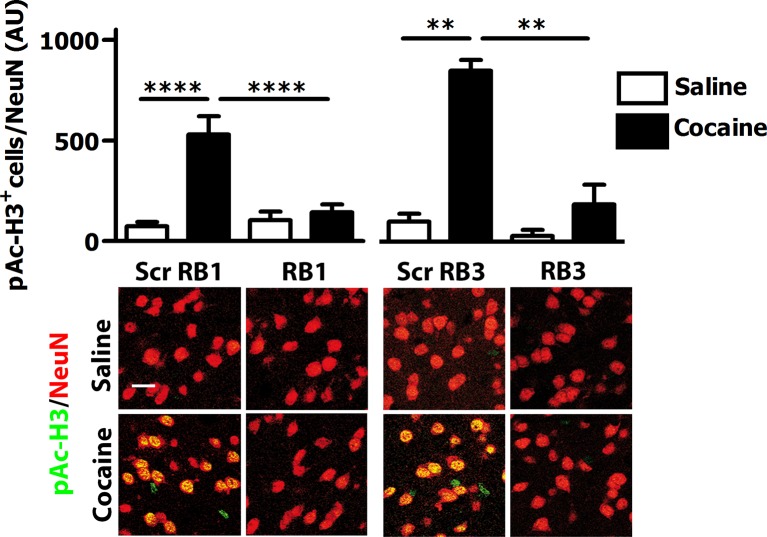
RB1 and RB3 have an inhibitory effect on cocaine-induced H3 phosphorylation.RB1 (20 mg/kg, i.p.), RB3 (20 mg/kg, i.p.) or the scrambled peptides (Scr RB1 and Scr RB3, 20 mg/kg, i.p.) were administered to wild type mice 1 hr before an acute cocaine (25 mg/kg) or saline injection. After 20 min mice were perfused. Co-labelling was performed with anti-phospho (Ser10)-acetyl (Lys14) histone H3 (in green) and NeuN (in red, scale bars 30 μm). Neuronal quantification shows a significant inhibitory effect of RB1 and RB3 on cocaine-induced H3 activation in the ventral striatum. Two-way ANOVA: effect of RB1 F1,32 = 10.29, p<0.01, effect of cocaine F1,32 = 19.91, p<0.001, effect of interaction F1,32 = 13.99, p<0.001; Bonferroni’s post-hoc, Scr RB1 saline (n=9) vs Scr RB1 cocaine (n=9) p<0.0001, Scr RB1 cocaine (n=9) vs RB1 cocaine (n=9) p<0.0001. Two-way ANOVA: effect of RB3 F1,14 = 9.90, p<0.01, effect of cocaine F1,14 = 14.84 p<0.01, effect of interaction F1,14 = 6.09, p<0.05, Bonferroni’s post-hoc, Scr RB3 saline (n=4) vs Scr RB3 cocaine (n=5) p<0.01, Scr RB3 cocaine (n=5) vs RB3 cocaine (n=5) p<0.01. **p<0.01, ****p<0.0001. Data are shown as mean with SEM.